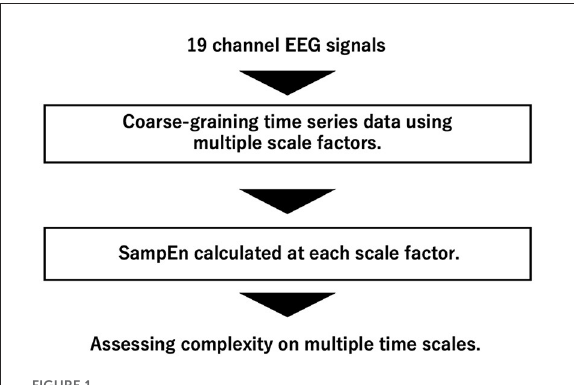
FIGURE1 Overview of complexity analysis of EEG signals by multi-scale entropy (MSE)